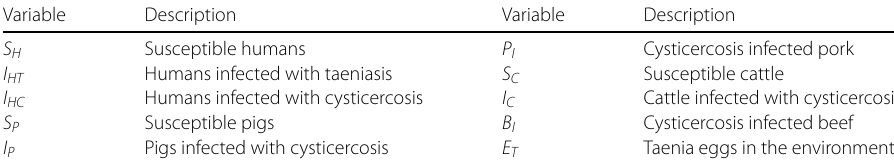
Table 1 Description of the state